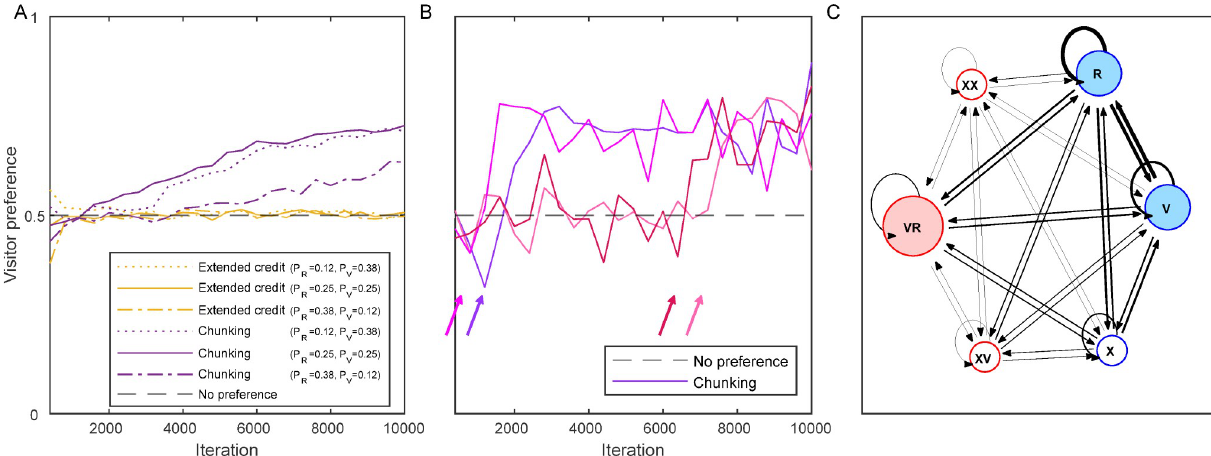
Fig 4. Simulations of the ‘natural market problem’. (A) The preference for a visitor by the extended credit model (yellow) and the chunking model (purple) are presented for client density ( 1-P ) of 0.5 and for 3 different distributions of client types: P = 0.12 and P = 0.38 (dotted lines), P = 0.25 and 0 R V R P V = 0.25 (solid lines), and P R = 0.38 and P V = 0.12 (dotted dashed lines). Black dashed line–no preference (0.5). C p = 2 (for the chunking model). ( B) Four simulations of the chunking model in the ‘natural market problem’ (with P R = 0.25 and P V = 0.25). Note how the preference towards a visitor sharply increases after the creation of the VR chunk (depicted with an arrow of a corresponding colour for each simulation). ( C) The internal representation of the chunking model at the end of a simulation as in (B) . Blue–basic (initial) elements, red–chunk elements, filled nodes–the relevant elements for the decision process. The size of the circle is relative to the value (association with food reward) of the element. The width of the directed edges (black arrows) is relative to the weight ( W ) of the transitions between elements. (Underlying data in S1 Data).